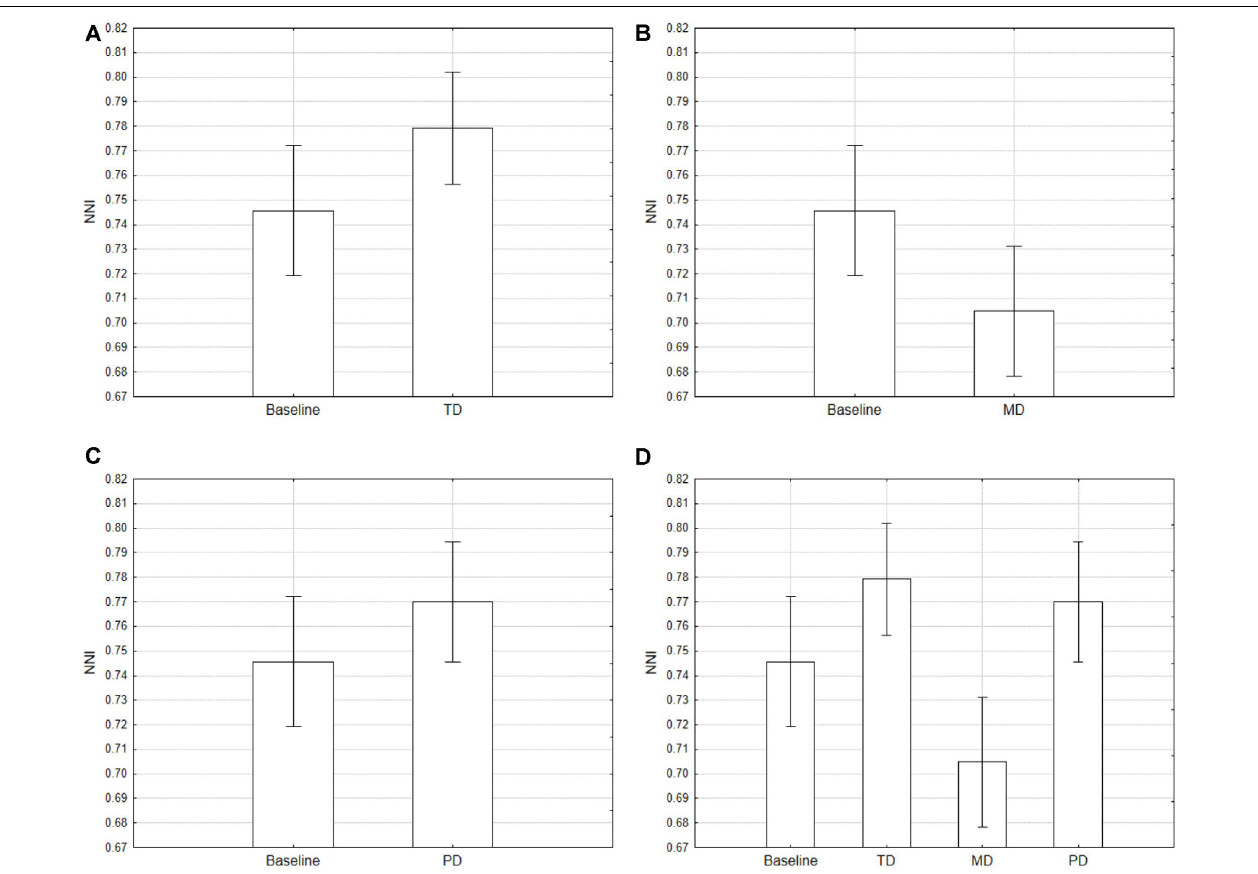
FIGURE 5 | Average Nearest Neighbor Index (NNI) for the conditions compared with the baseline separately. Error bars denote 0.95 confidence intervals. Baseline vs . TD (A) ; Baseline vs . MD (B) ; Baseline vs . PD (C) ; all condition (D) .